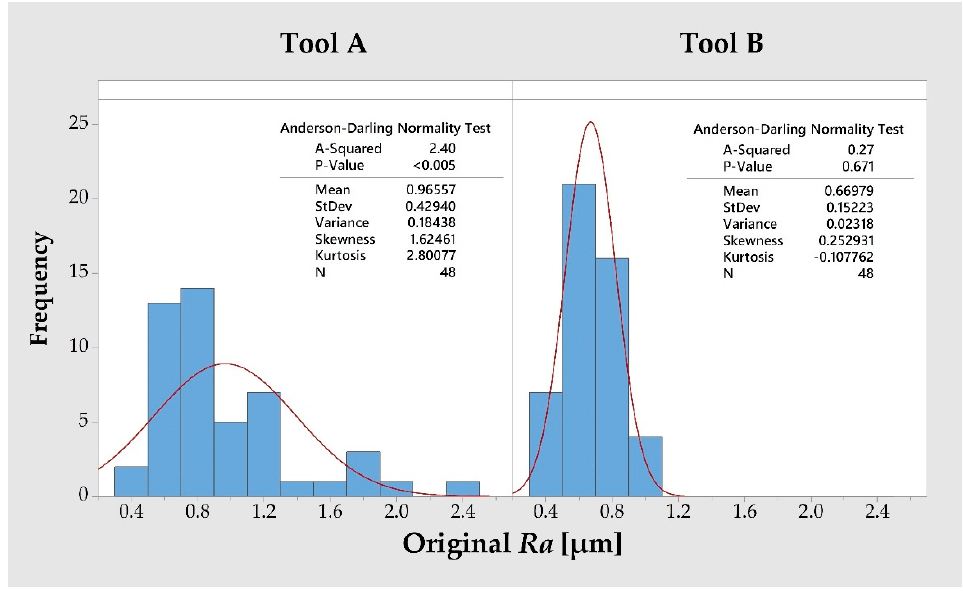
Figure 11. Histogram of data with an overlaid normal curve of the original Ra for tool types A and B.